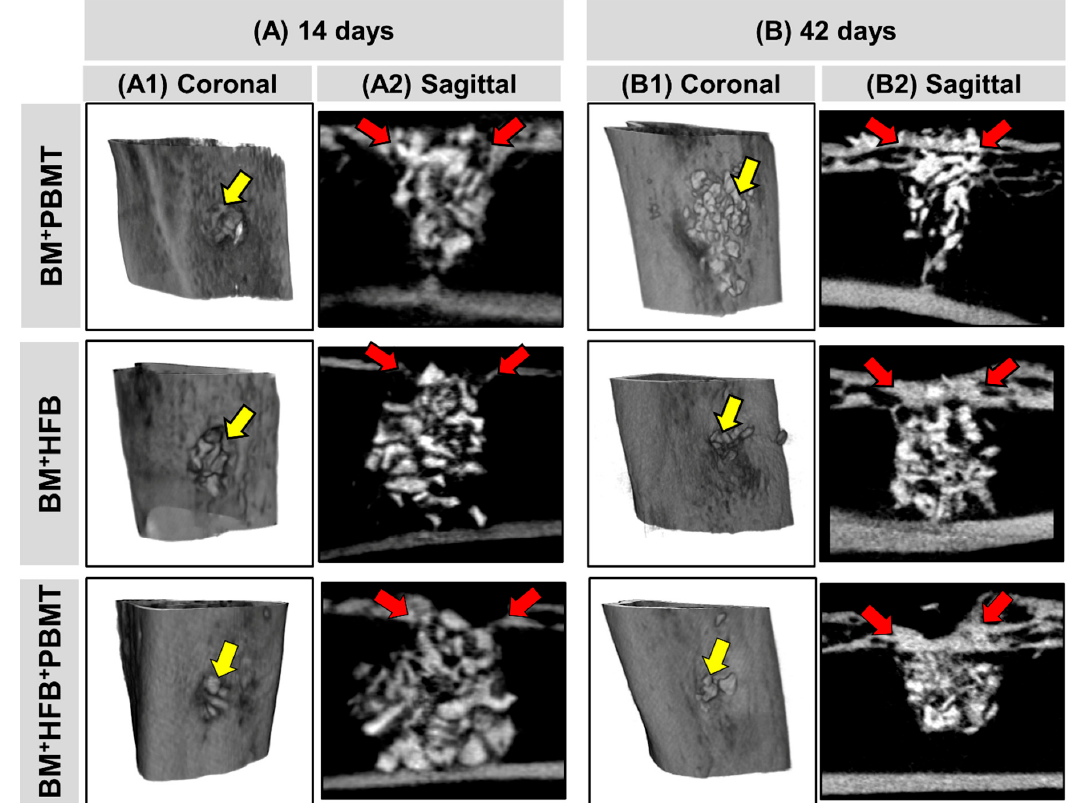
Figure 3. Representative microcomputed tomography (µCT) image of the proximal third of the tibia for each rat group: 1 (BM + PBMT) (lyophilized bovine bone matrix with photobiomodulation therapy), 2 (BM + HFB) (lyophilized bovine bone matrix plus heterologous fibrin biopolymer) and 3 (BM + HFB + PBMT) (lyophilized bovine bone matrix plus heterologous fibrin biopolymer with photobiomodulation therapy) in the periods of ( A ) 14 and ( B ) 42 days. ( A1 , B1 ) Three-dimensional coronal section shows the cortical region of the defect, biomaterial particles (yellow arrow). ( A2 , B2 ) Two-dimensional sagittal section shows the cortical and medullary region of the defect filled by BM, defect in the cortical bone (red arrows).